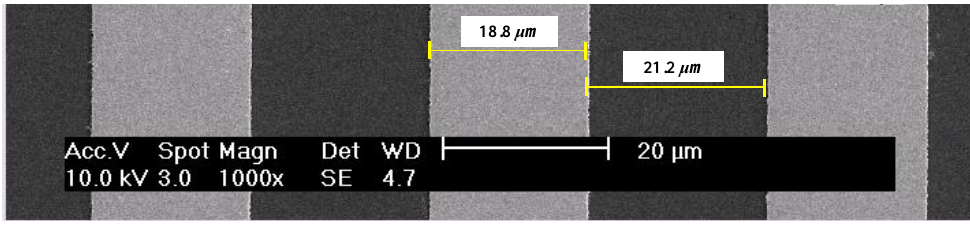
Figure 6. SEM images of surface at 20.0 µm grating.